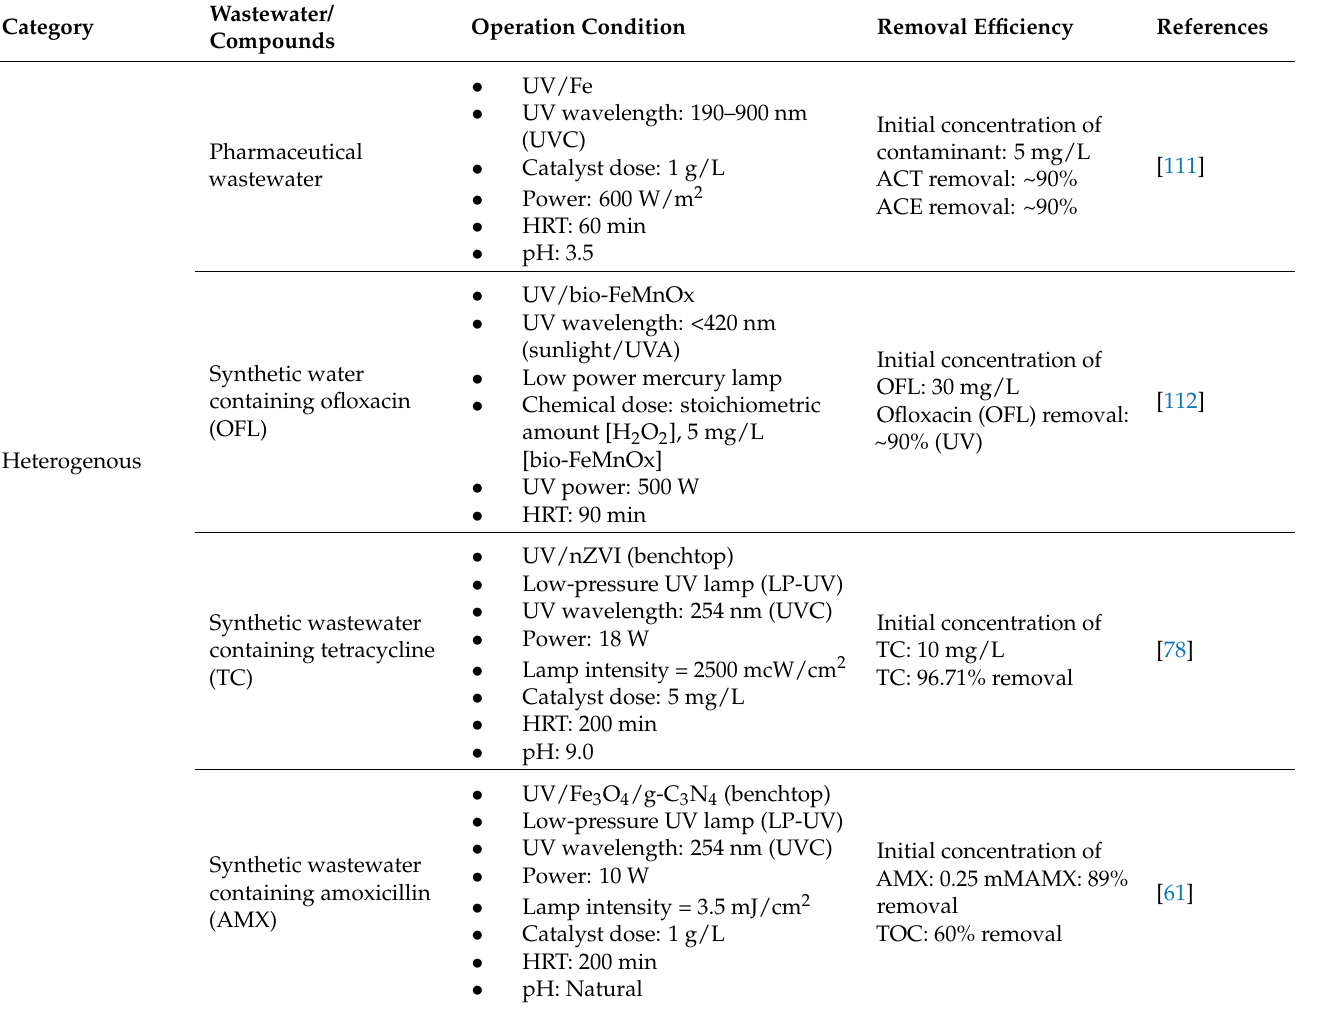
Table 6. Current application of photo-Fenton